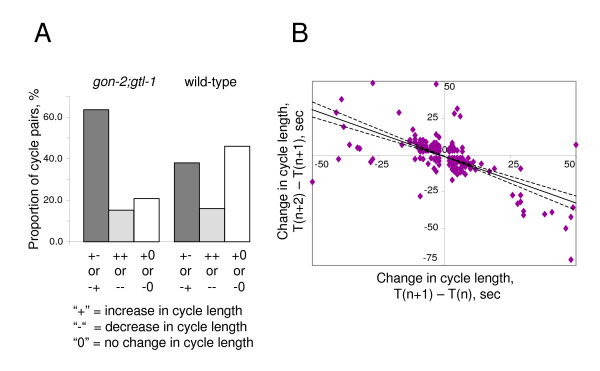
Analysis of the defecation cycle in gon-2(RNAi);gtl-1(RNAi) animals reveals compensatory behaviour in the oscillator. A: A histogram showing the frequency of the combinations of the direction of the change in cycle length for pairs of cycles. For each cycle we determined whether the period increased (represented by +), decreased (-) or remained constant (0). We then counted the number of cycle pairs which fell into each possible class. Those of classes "00", "0+" and "0-" are not shown. The frequency is shown as proportion of the total number of cycle pairs included in the analysis. B: A scatter plot of the change in period time in one cycle pair compared to the subsequent cycle pair for gon-2(RNAi);gtl-1(RNAi) animals. T(n) is the period of the cycle n. Linear regression was used to derive the line which, is shown with 95% confidence limits (dashed lines).